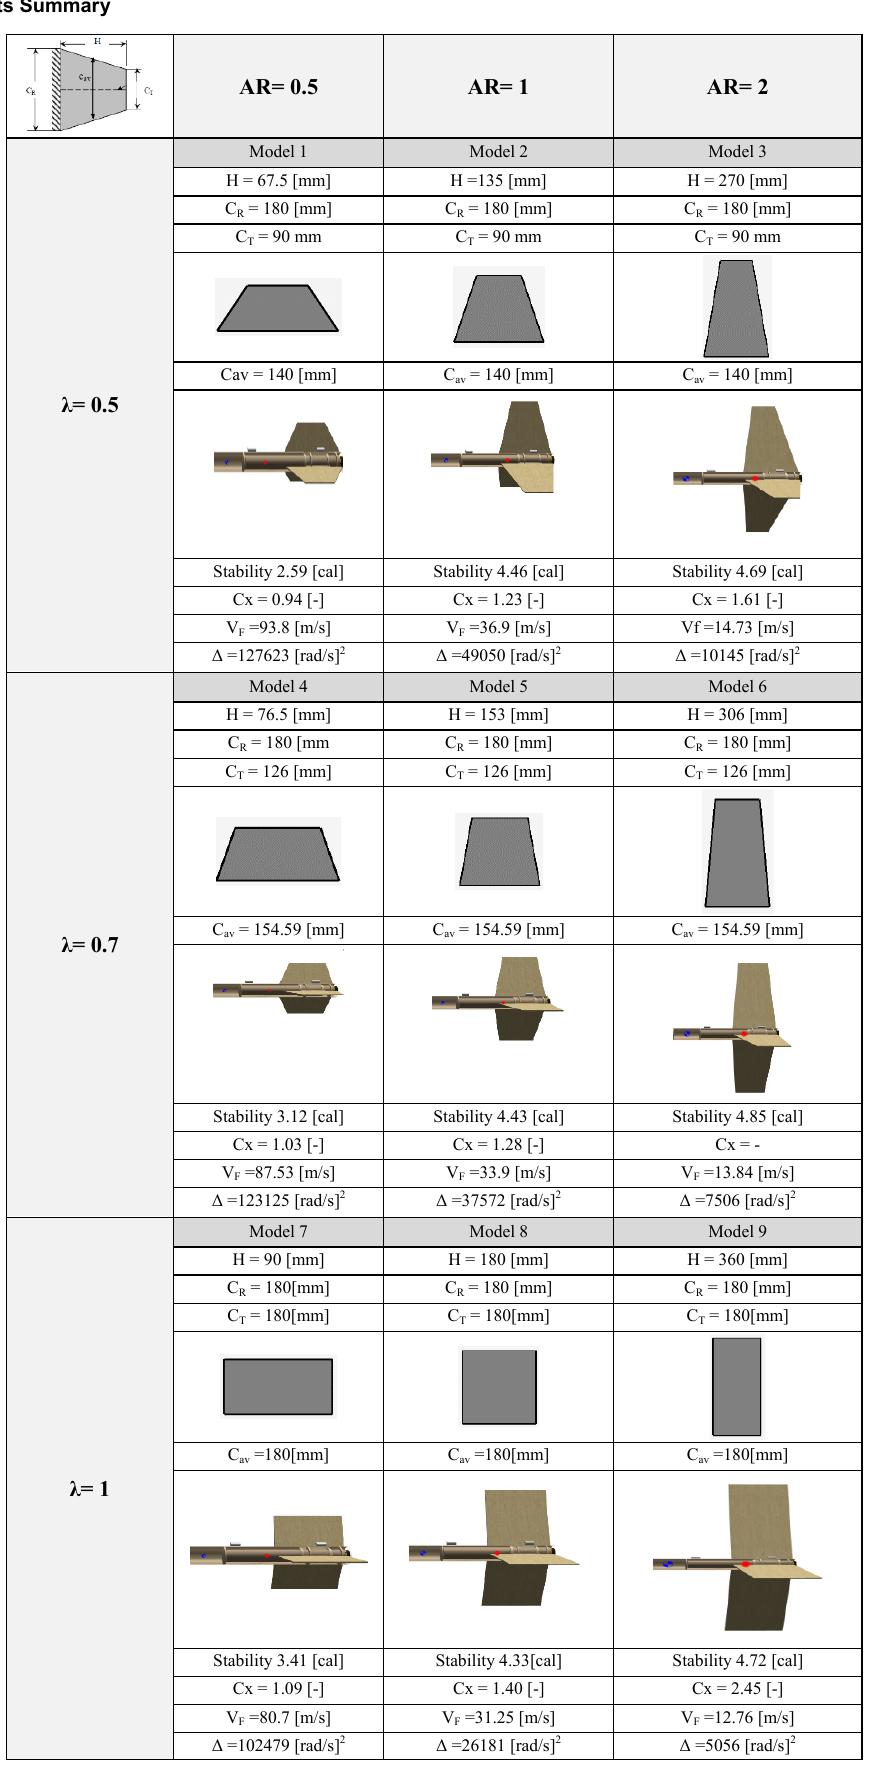
Table 4 Results